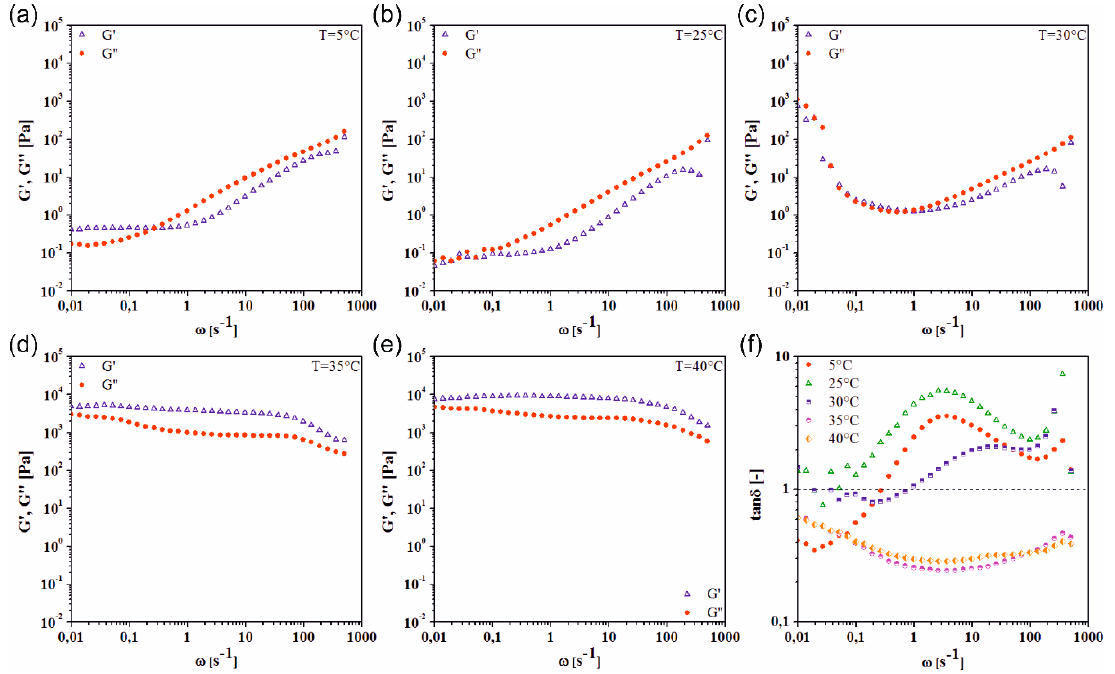
Figure 4. Relations of storage G’ and loss G” moduli ( a – e ) and damping factor tan δ ( f ) as a function of angular frequency ω for sample 3 at different temperatures.